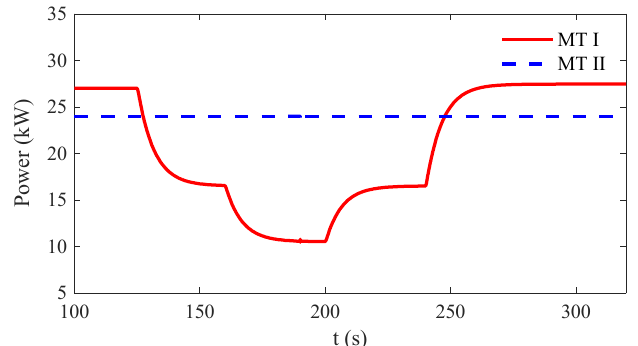
Figure 7. Variations of MT power output.